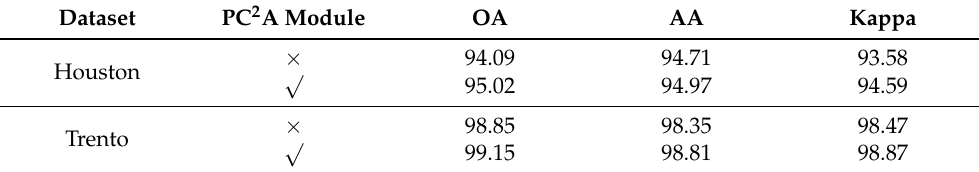
Table 8. Influence of with/without PC 2 A module on classification accuracies.